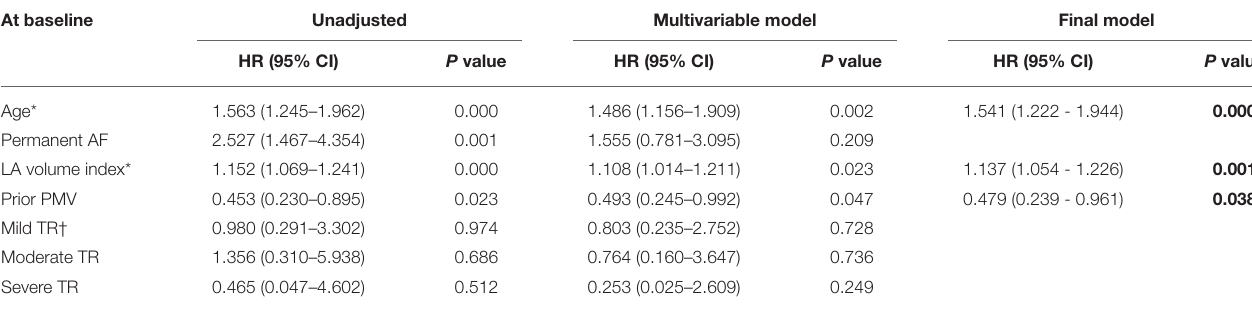
TABLE 3 | Clinical and echocardiographic characteristics associated with MR progression in patients with RHD: Cox regression model. At baseline Unadjusted Multivariable model Final